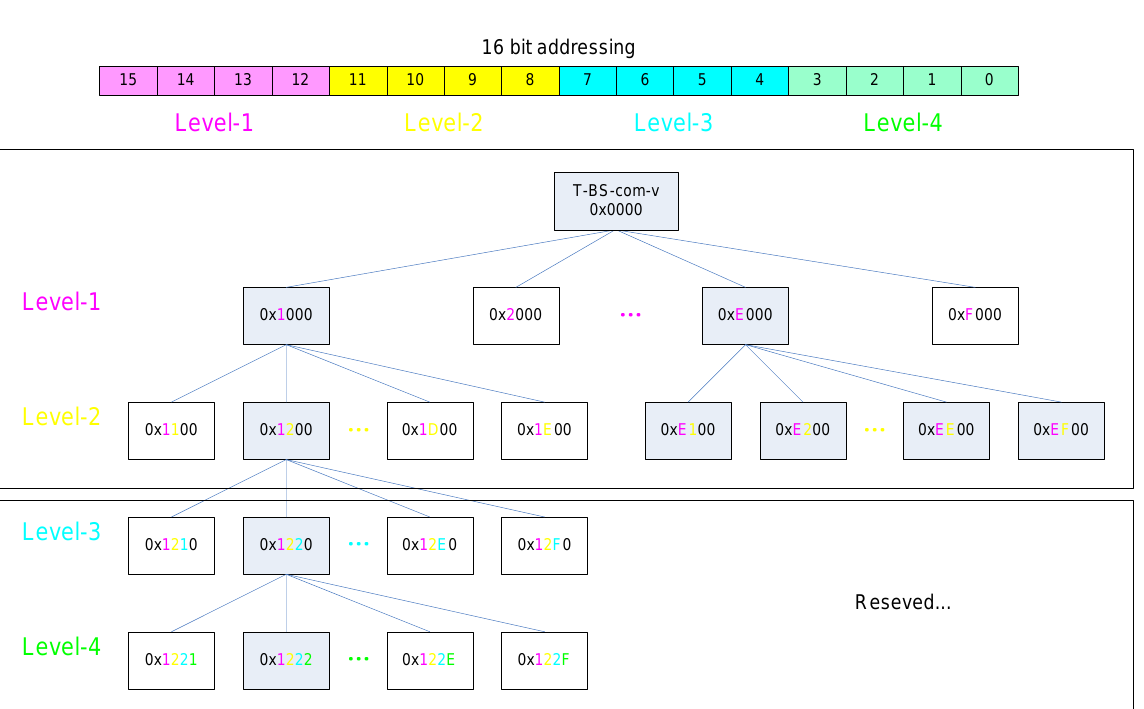
Figure 2. Level based Static Addressing scheme for a fast and light weight routing algorithm for SCN. Each rectagular box including a hexadecimal number represents a sensor node (e.g., T-Sink-v, T-Sensor-v, T-Act-v, etc.) in SCN, and the hexadecimal number is the assigned address for each node.